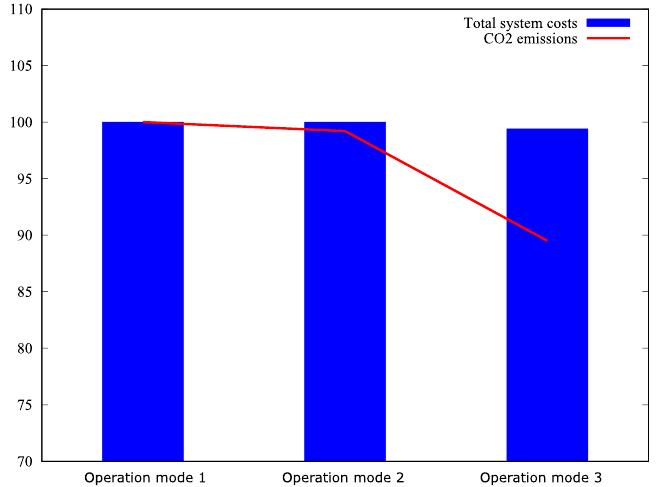
Figure 8. Annualized total system costs and CO 2 emissions, normalized in % of respective values for battery operation mode 1 by battery operation mode for a 50% prosumer penetration ratio under consideration of widespread e-mobility.